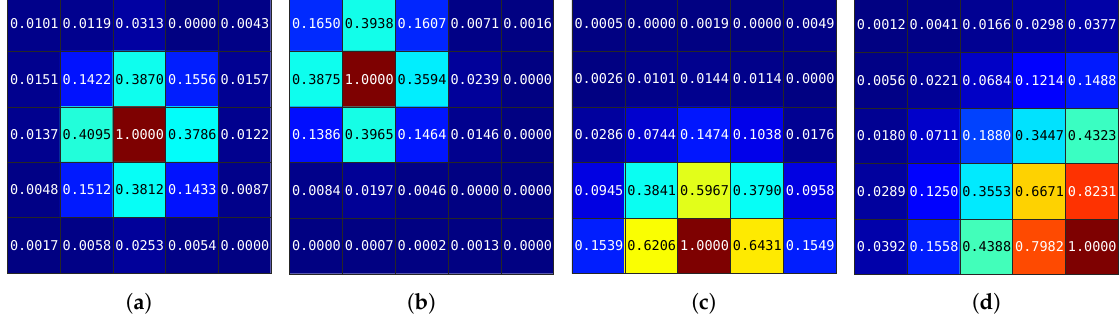
Figure 4. Received power when the laser module MDL-H-808 was located away from the 5S1010.4-A555555 VMJ PV cell array: suitable experimental setup in Table 1 is ( a ) setup #1, ( b ) setup #2, ( c ) setup #3, and ( d ) setup